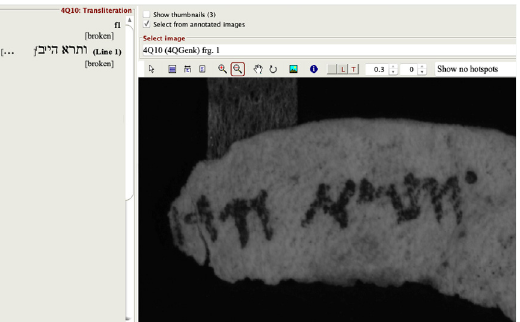
Figure 19: Image of 4Q10 with transcription ; image used by permission of the Israel Antiquities Authority